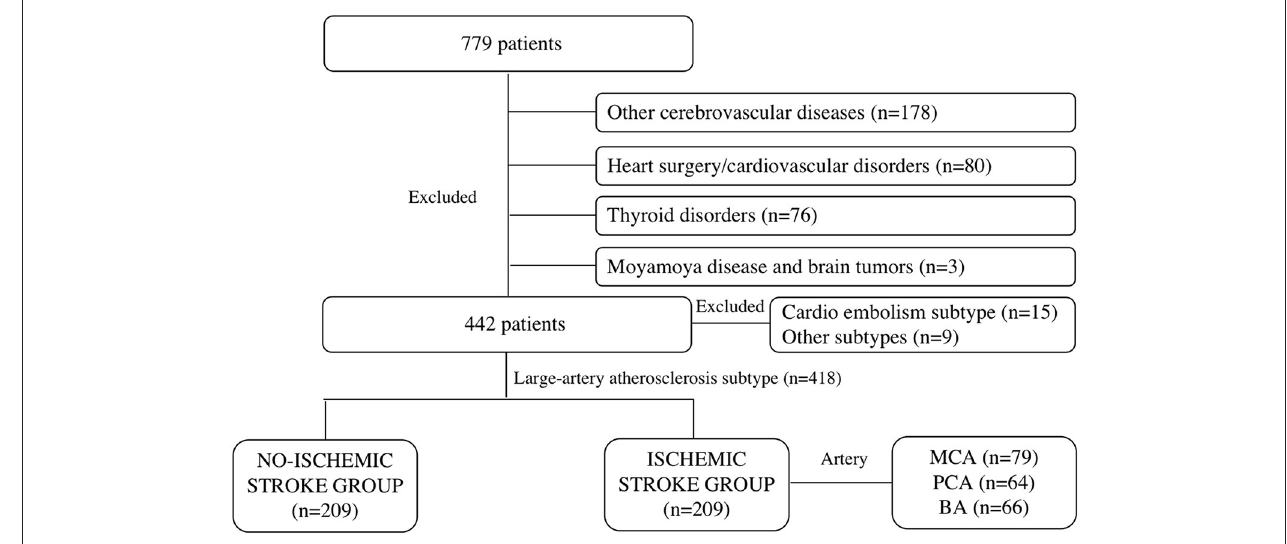
FIGURE 1 | Flow diagram for patient population of ischemic